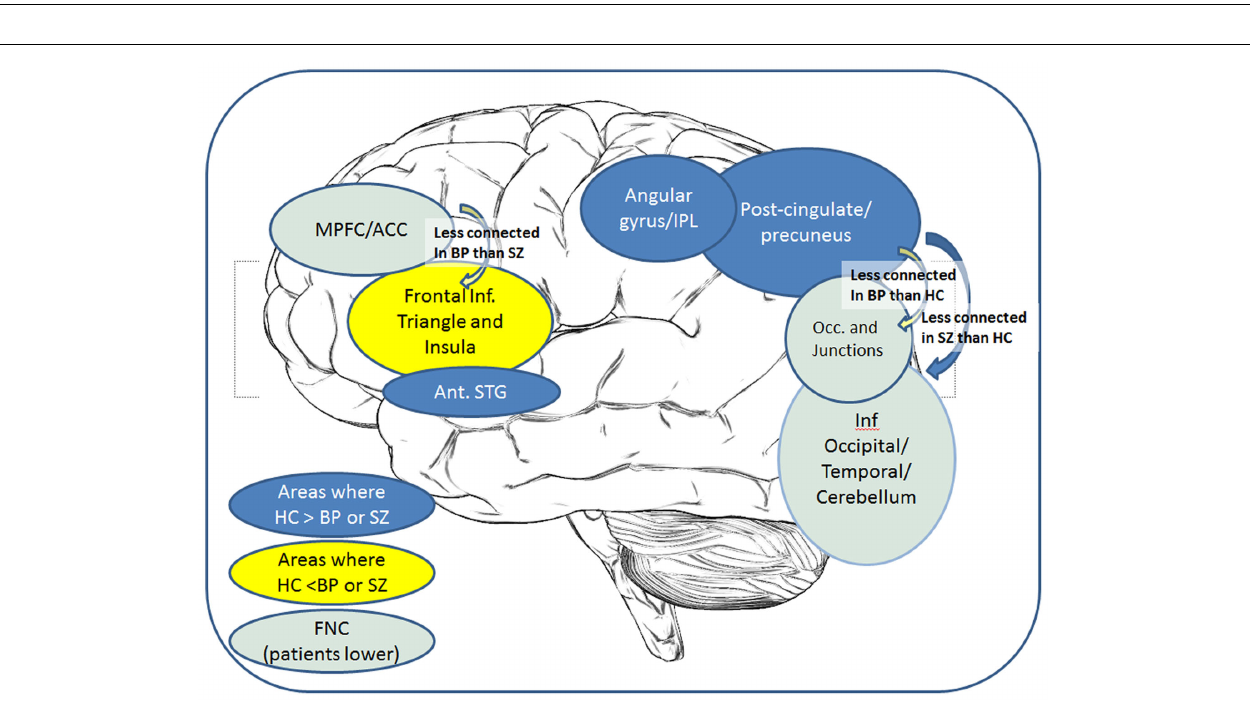
FIGURE 3 | Spectra: between-group differences in spectral power (thresholded at p < 0.05, corrected for multiple comparisons) for Healthy – Schizo (top) and Healthy – Bipo (middle) contrasts. Note that the Schizo – Bipo contrast showed no significant differences.